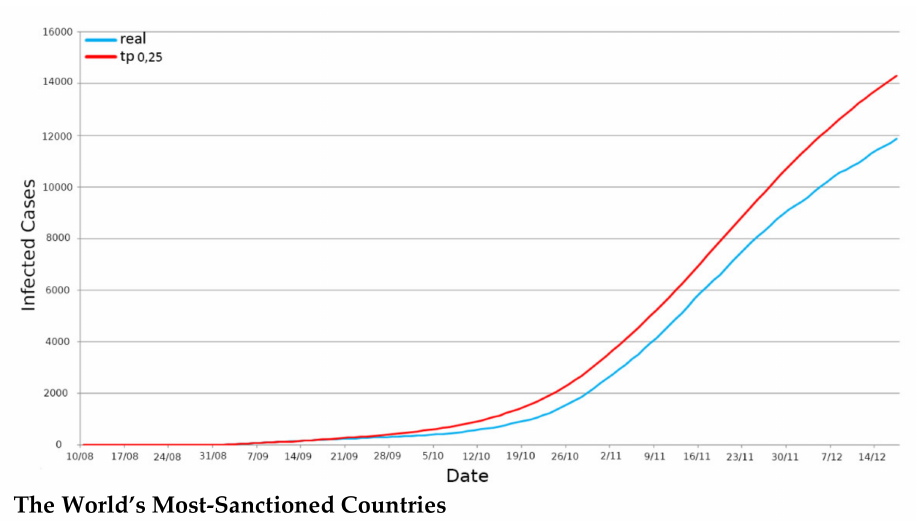
Figure 13. Positives’ incremental representation—Emilia Romagna